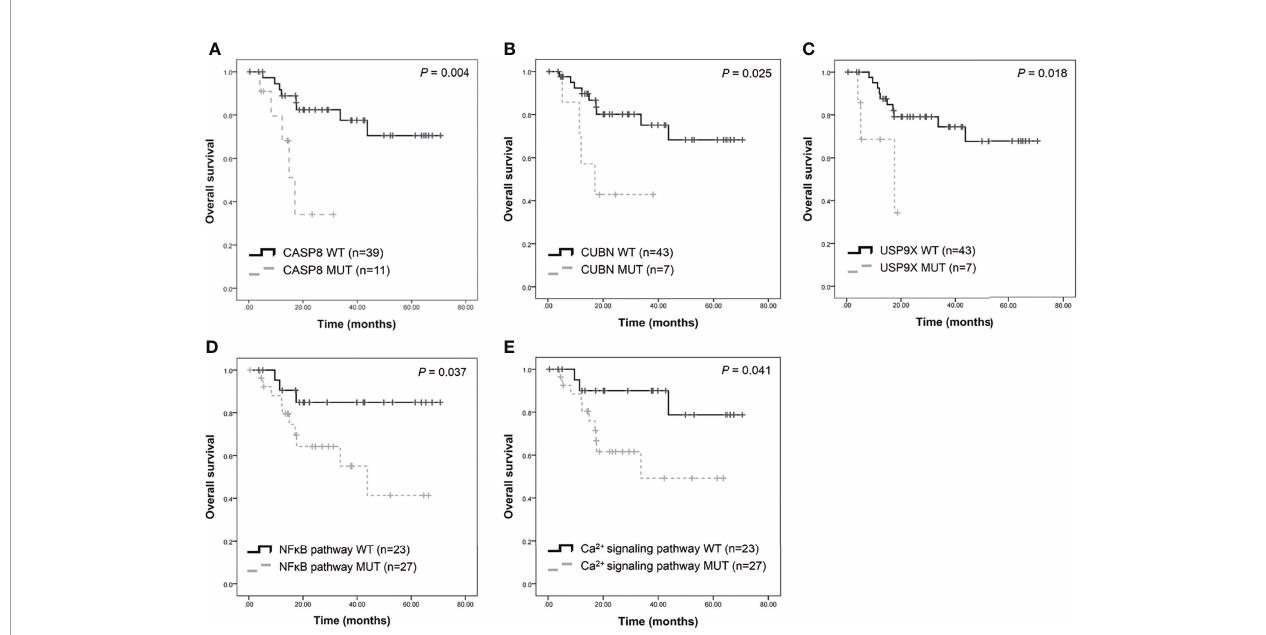
FIGURE 6 | Survival analysis of candidate genes in patients with OSCC. Kaplan-Meier plots of overall survival based on CASP8 mutation (A) , CUBN mutation (B) , USP9X mutation (C) , NF k B (D) , and calcium signaling pathway (E) status.